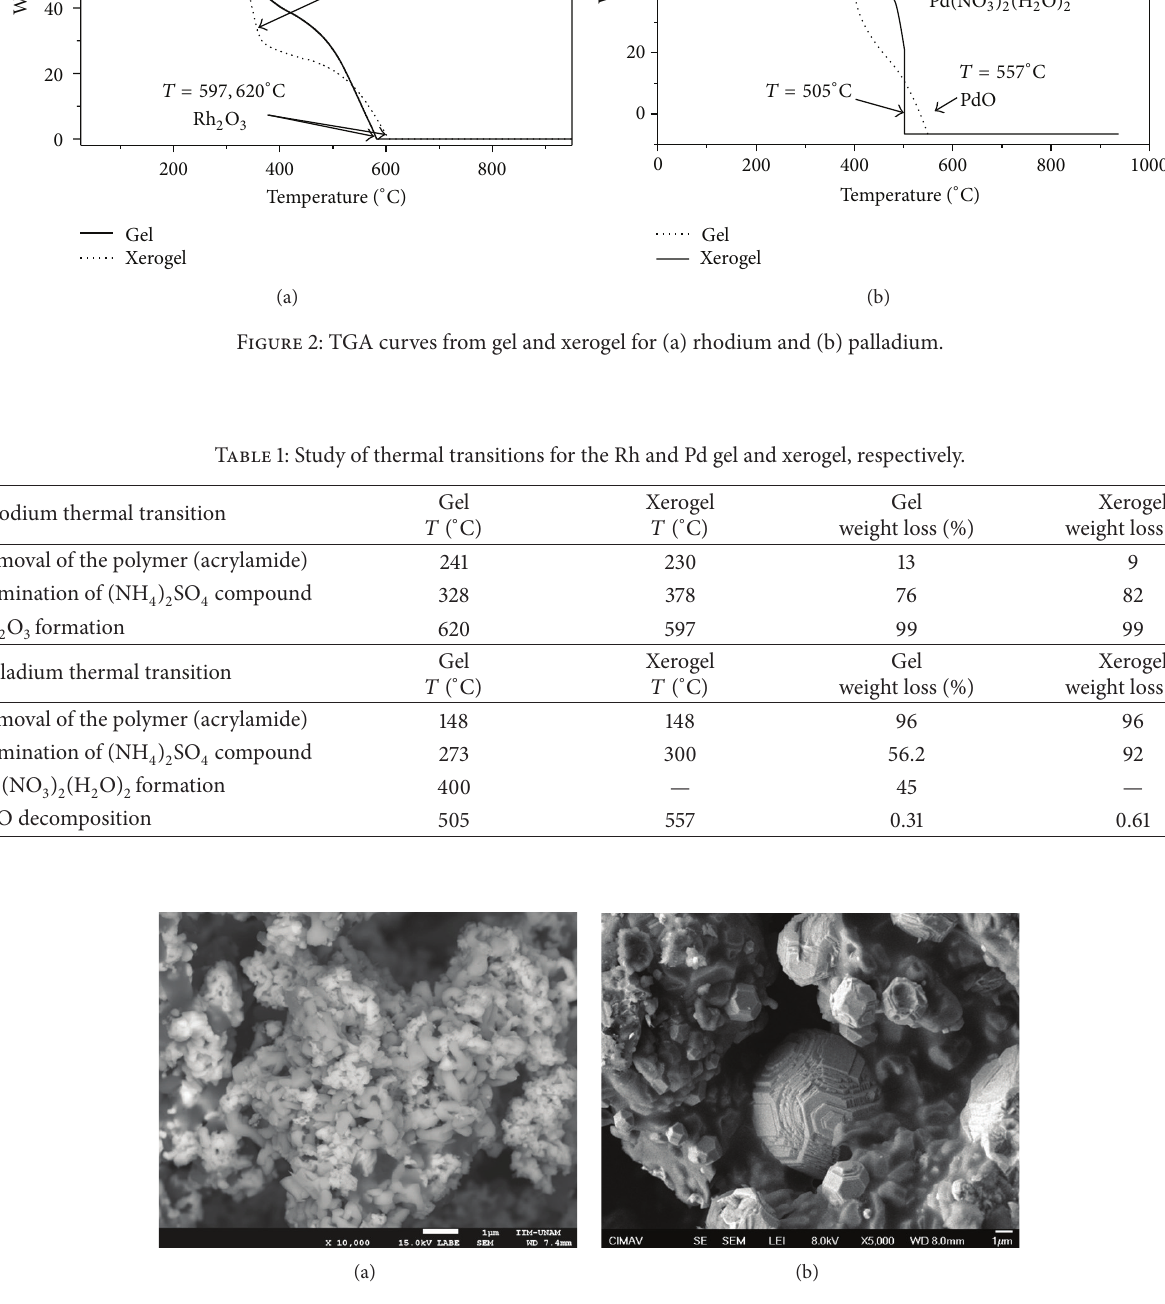
Figure 3: SEM analysis for the (a) material before the heat treatment and (b) Rh-Pd alloy powders after applying the heat treatment at 1000 ∘ C for